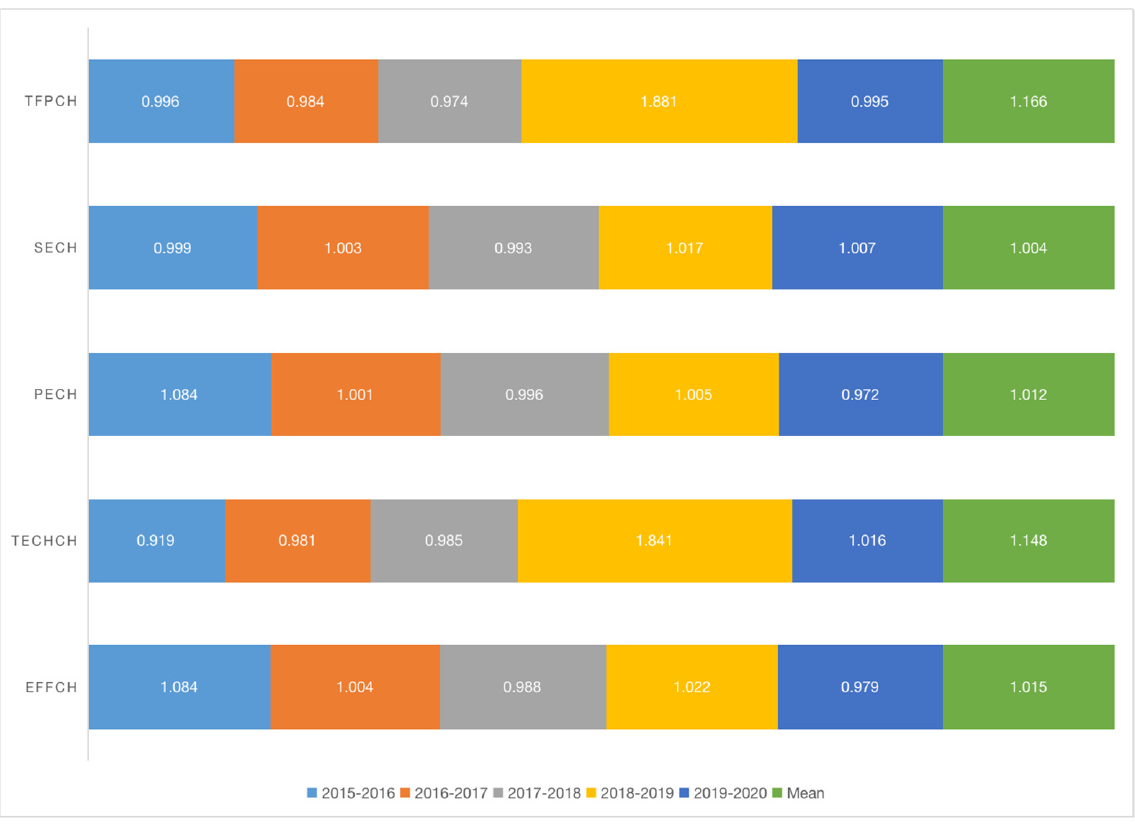
Figure 3. Malmquist index and decomposition of RLI eco-efficiency in Anhui from 2015 to 2020.